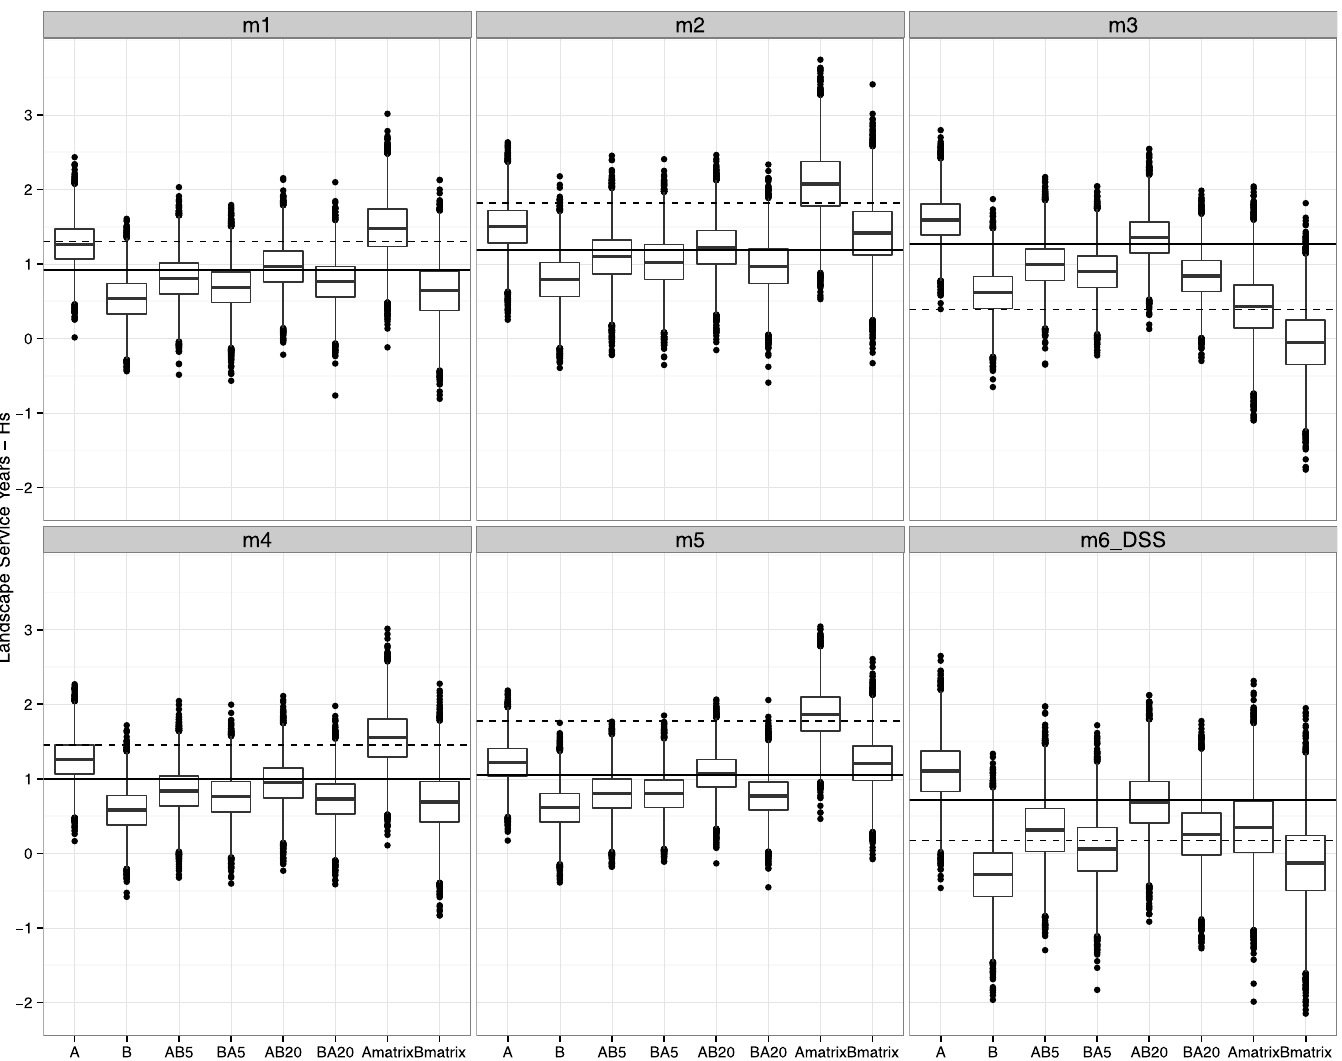
Fig 3. Landscape Service Years for average expected heterozygosity within breeding groups (Hs). Solid horizontal line represents the number of credits available in the bank, prior to a trade, assuming a static matrix and the dashed horizontal line is the number of credits available under a declining matrix. Boxplots of bootstrapped credit values remaining after each trade, with bars represent median values, the box represents the upper and lower 25 th quartile, whiskers represent max/min values excluding outliers, and dots represent outliers, or values 1.5 x 25 th